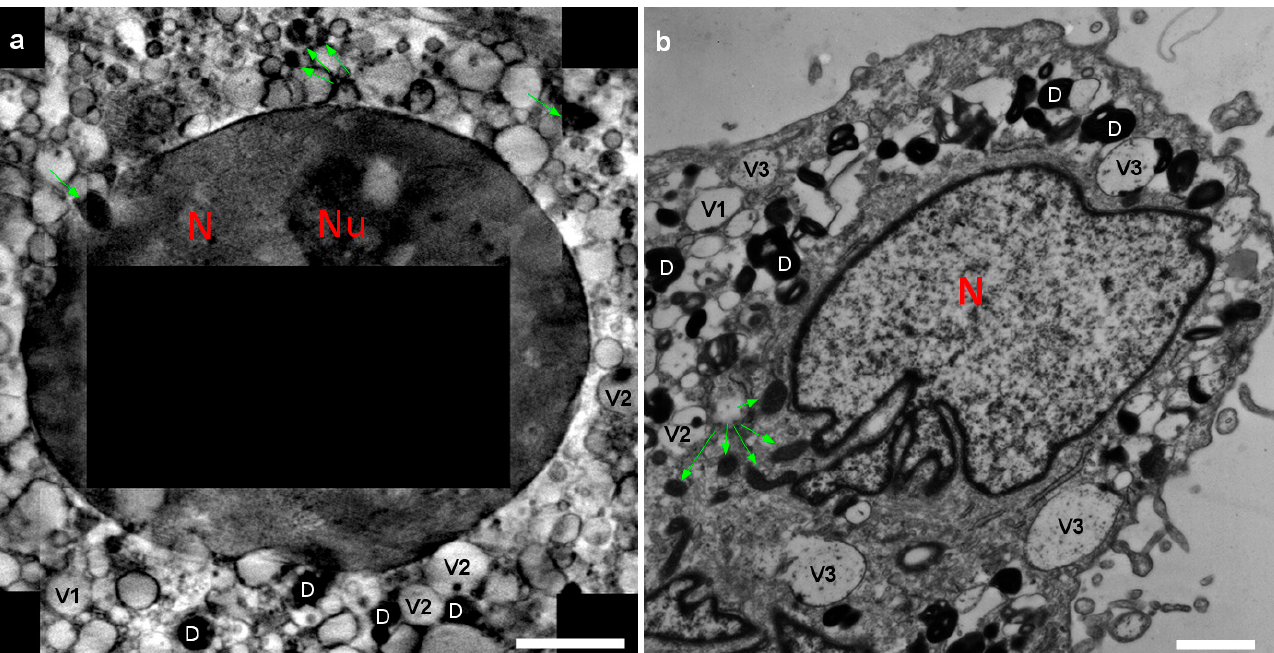
Figure 2. ( a ) bMSC-4D detail from the cryoSXT reconstruction slice reported in Figure 1a with letters and arrows indicating different objects inside the cell. Nucleus (N), mitochondria (green arrows), lipid droplets, vesicles (V1 and V2), and dense objects (D). Scale bar is 3.4 μ m. ( b ) bMSC-4D TEM image. Despite the different sample preparation (cryo vs. dried and stained) and the different thicknesses tackled with each technique, we can still recognize the same objects indicated in ( a ) (same labeling was used for V1 and V2, V3 which represent vesicles containing smaller dense objects). It is possible to notice that the contrast in 2a is quantitative (related to the elements contained in each tomogram voxel), while the TEM image is not as the contrast is produced by the staining. In addition, the global shapes are better preserved in the cryo preparation (e.g., nucleus). Scale bar is 1 μ m.